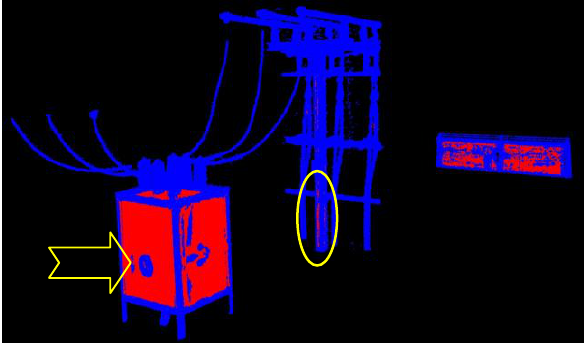
Figure 8. Segmentation results of PCA using Leica subset